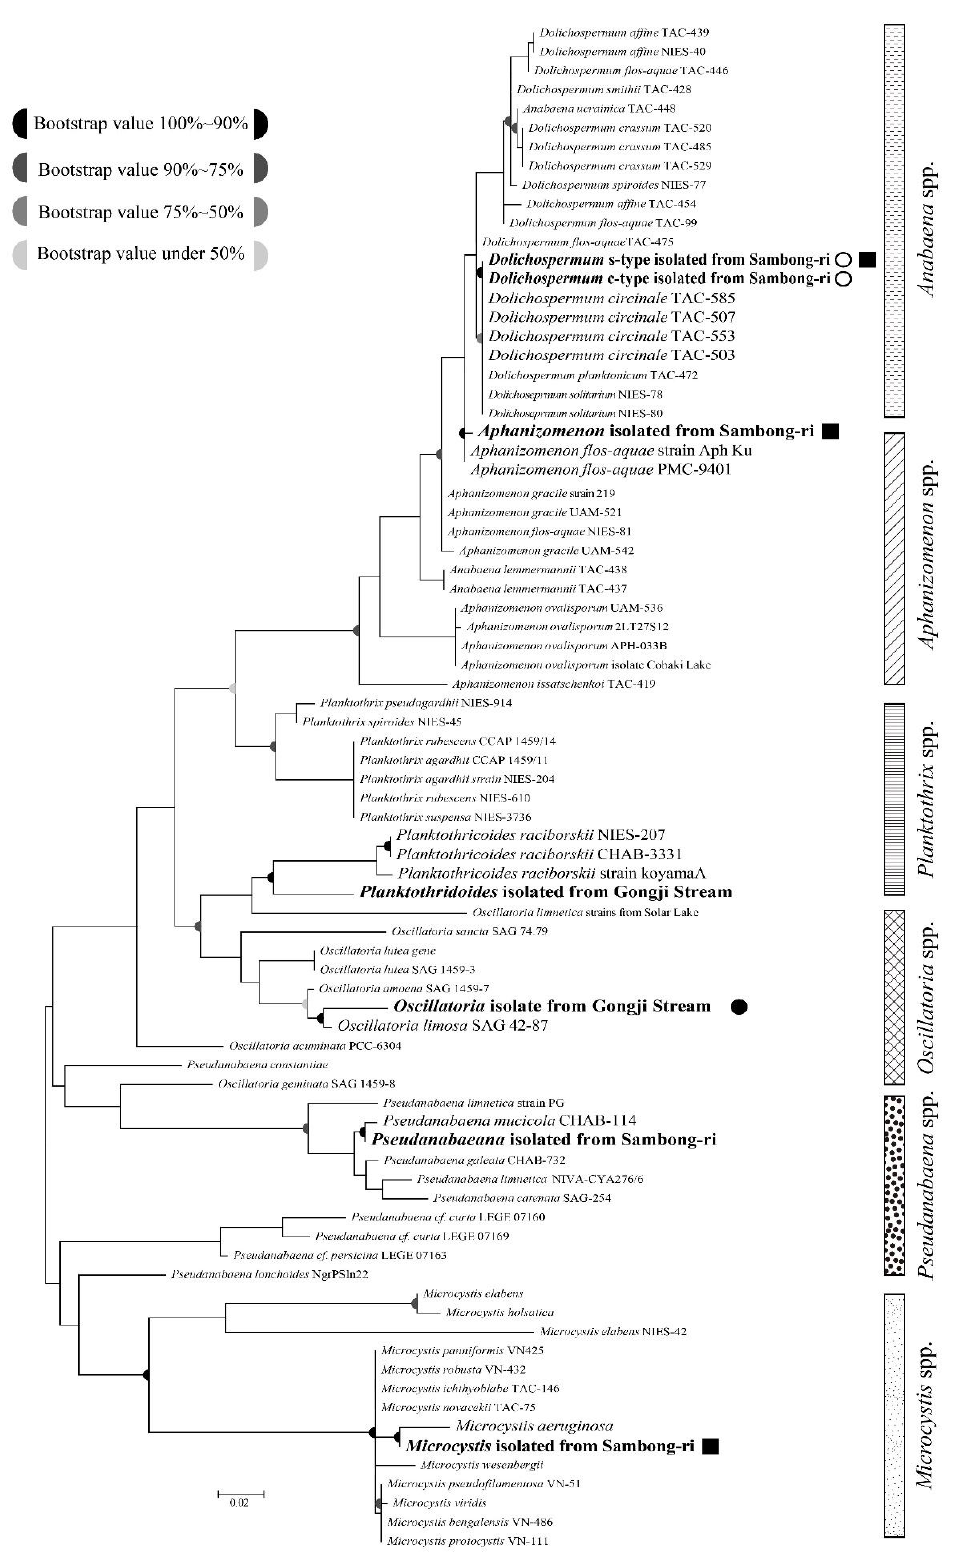
Figure 2. Phylogenic relationships of Nostocales, Oscillatoriales, Synechococcales, Chroococcales taxa. White circles indicate the cyanobacterial strains isolated from the North Han River. The former name of the genus Dolichospermum is Anabaena . Open circles: geosmin-producing cyanobacteria, black circles: 2-MIB-producing cyanobacteria, black squares: microcystin-producing cyanobacteria.